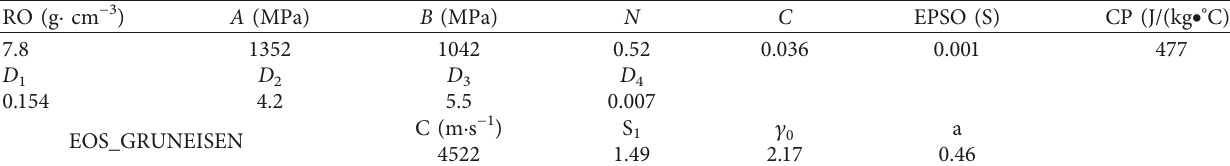
Table 3: Basic parameters of the